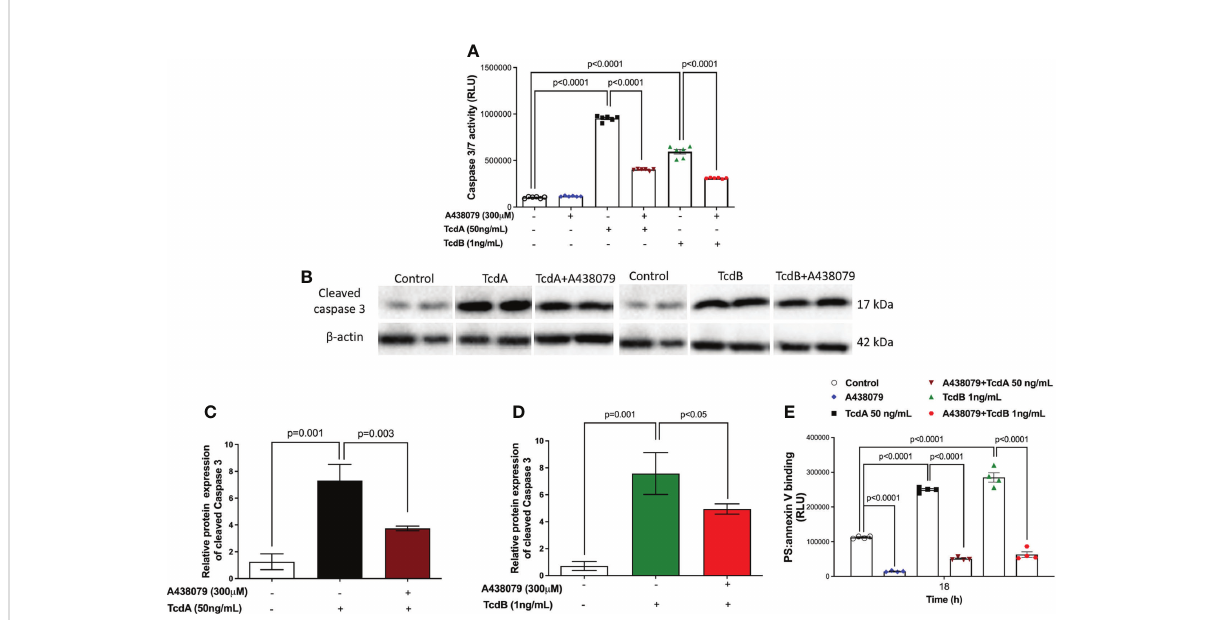
FIGURE 5 A438079, a P2X7R antagonist, prevents TcdA- and TcdB-induced EGCs death. (A) Activity of caspase 3/7 analyzed by luminescence assay in EGCs incubated for 18 h with TcdA, TcdB by qPCR. A438079, a P2X7R antagonist, was added to EGCs one hour prior to toxin challenge. (B) Representative Western Blot images showing the prevention of TcdA and TcdB induced cleavage of caspase 3 protein expression by A438079, a P2X7R antagonist. b -actin was used as a loading control. The WB images for the control group are the same for both toxins. (C, D) Graphs represents cleaved relative protein expression of caspase 3. The data are the mean ± SEM. One-way ANOVA followed by the Tukey test was used. (E) A438079 (P2X7R antagonist) prevented cell death analyzed by RealTime-Glo annexin V apoptosis assay in EGCs. The data are the mean ± SEM. Two-way ANOVA followed by Tukey test was used. p value is represented in the